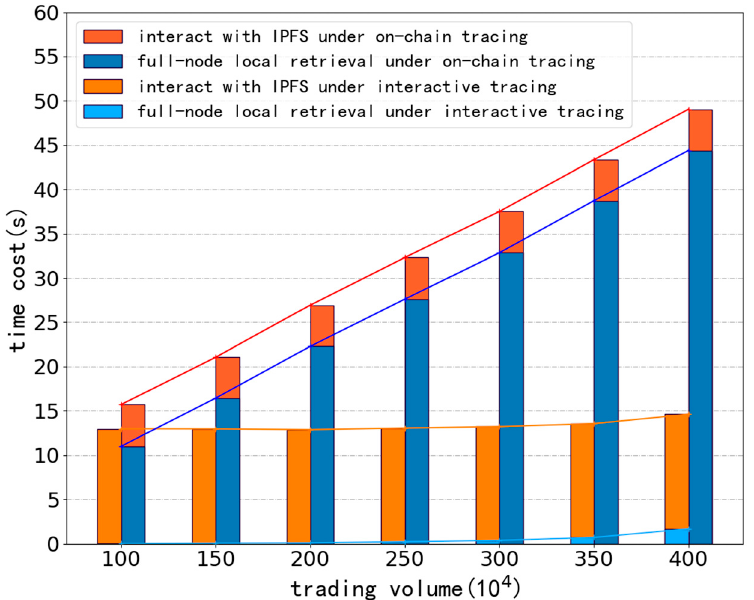
Figure 8. Comparison of traceability efficiency between two different traceability processes.